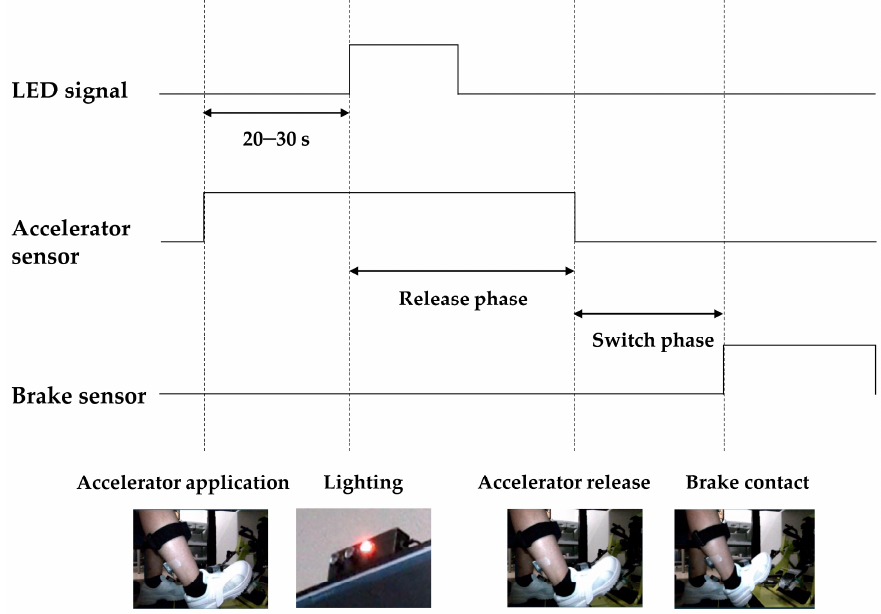
Figure 2. Separation of the phases of the braking action.